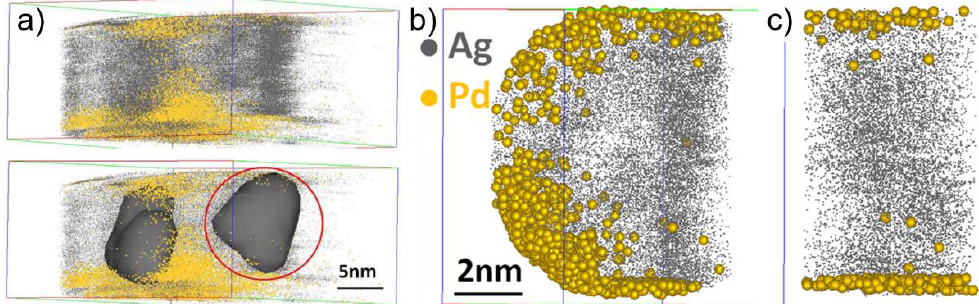
Figure 7. Analysis of Ag@Pd nanoparticles prepared by the electrophoresis method. ( a ) Atom map of Ag@Pd nanoparticles with 1:1 ratio showing two distinct particles (highlighted by applying the isosurface method in the bottom part); ( b ) local reconstruction of one single particle; and ( c ) slice through an individual nanoparticle showing the presence of a Ag core and a one to two atomic layer Pd shell. Reprinted by permission from Nature: [120], Copyright (2011).